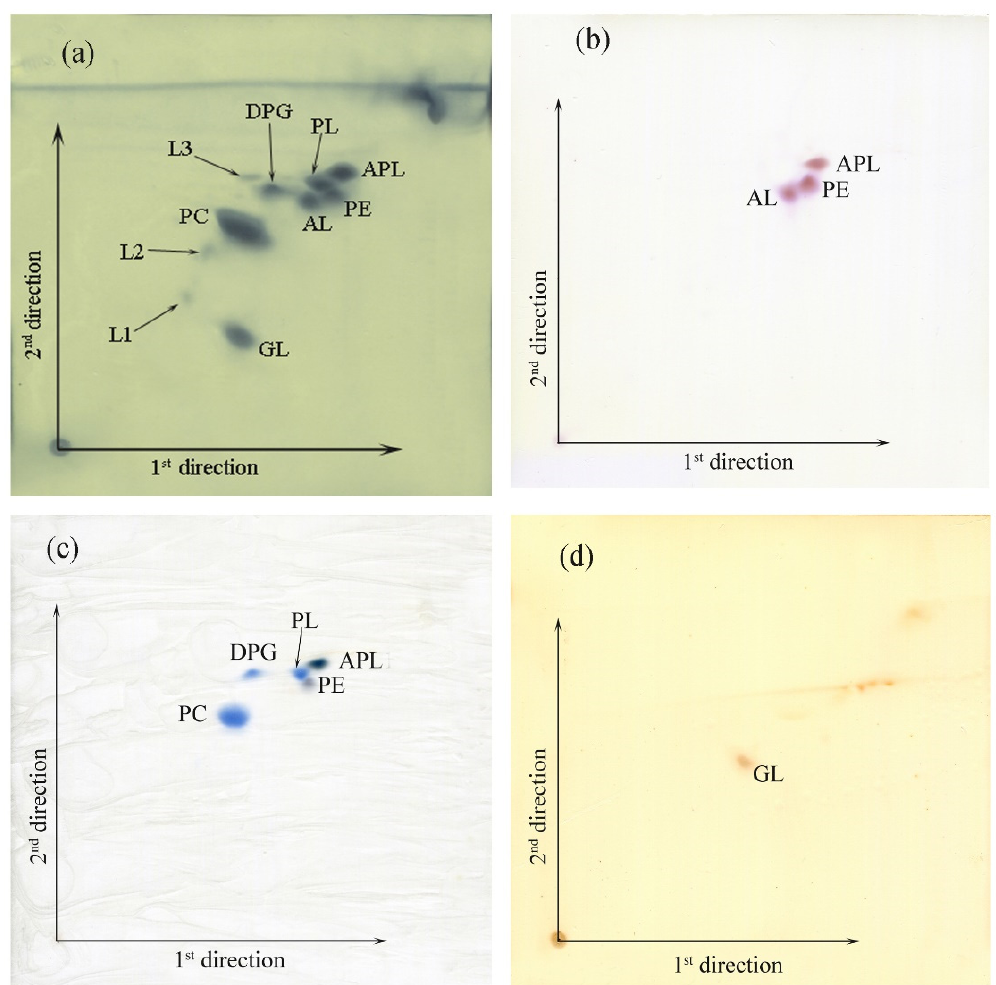
Figure 6. Thin-layer chromatograms of the polar lipids from strain S-51 T . The components were seen by staining with 5% molybdophosphoric acid in ethanol and heating them at 180 ◦ C for 15 min ( a ); ninhydrin at 110 ◦ C for 15 min ( b ); molybdenum at room temperature ( c ); and α -naphthol-sulphuric acid at 110 ◦ C for 15 min ( d ). Abbreviations: PE, phosphatidylethanolamine; PL, unidentified phospholipid; DPG, diphosphatidylglycerol; PC, phosphatidylcholine; GL, unidentified glycolipid; AL, unidentified aminolipid; APL, aminophospholipid; L1–L3, unidentified polar lipids. Table 4. Cellular fatty acid profiles (% of total) of strain S-51 T and closely related reference strains. Strains: 1, S-51 T ; 2, Rhizobium naphthalenivorans KCTC 23252 T ; 3, Rhizobium selenitireducens